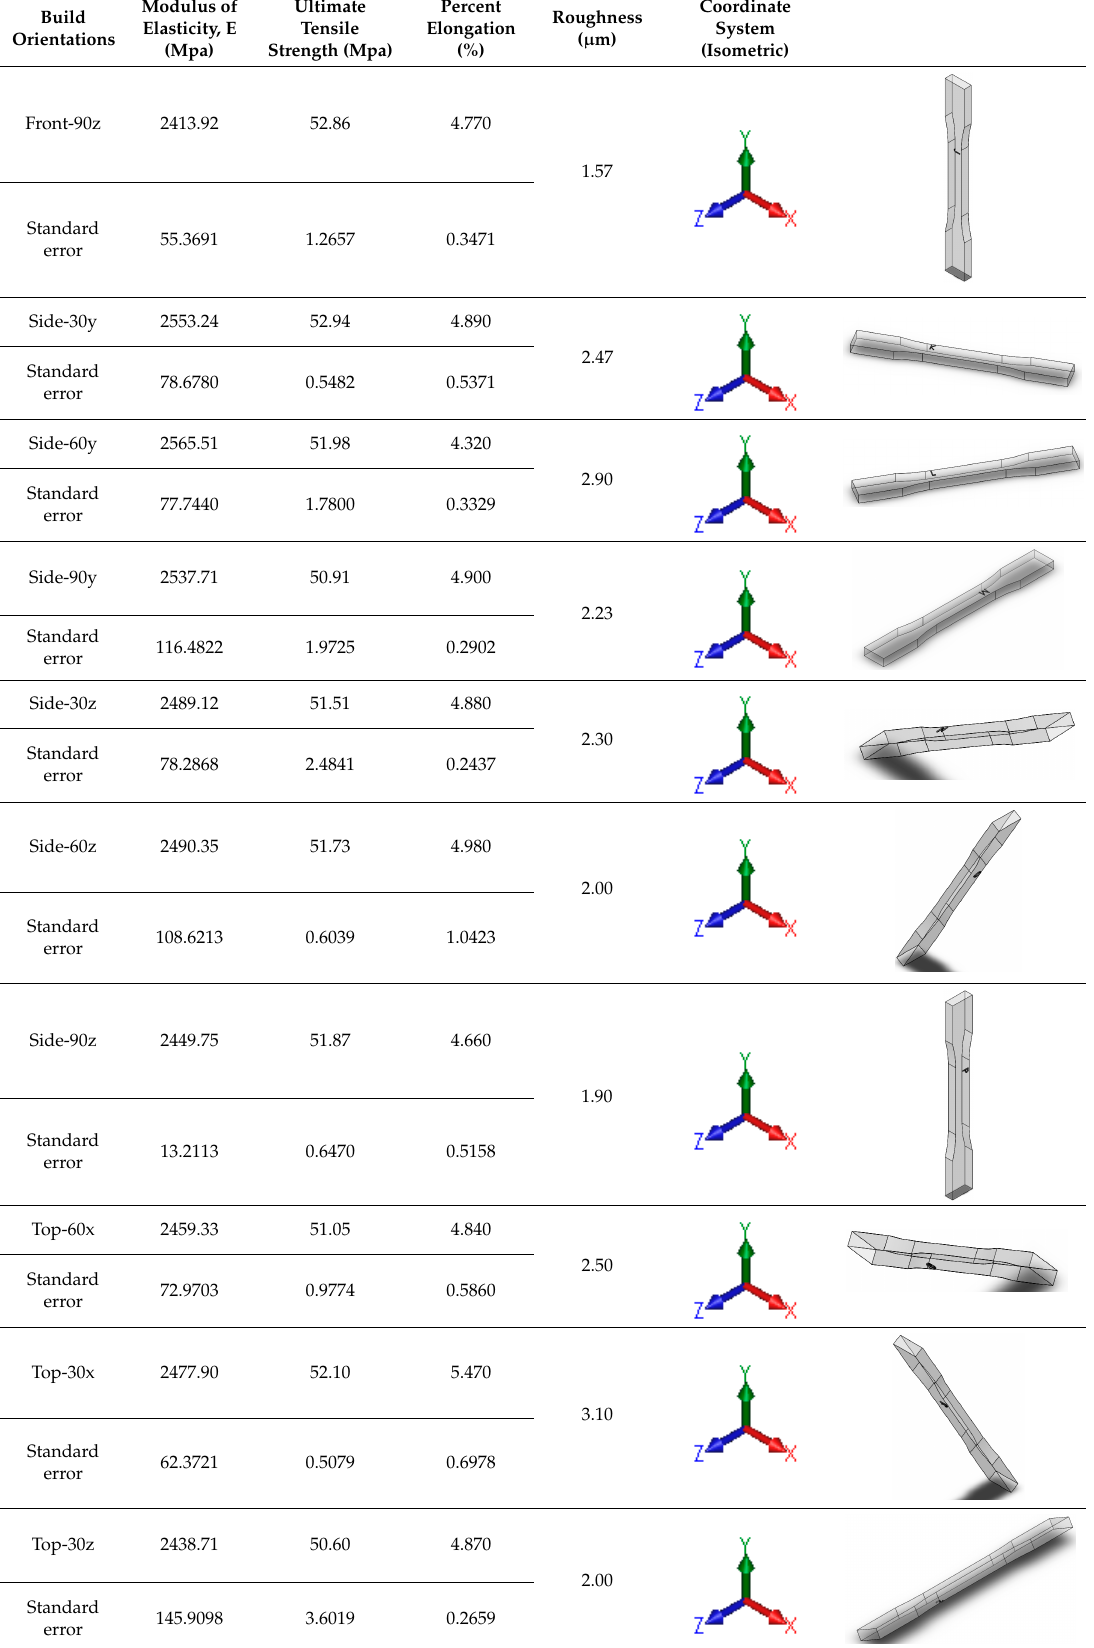
Figure 9. The mean surface roughness for the different orientations.